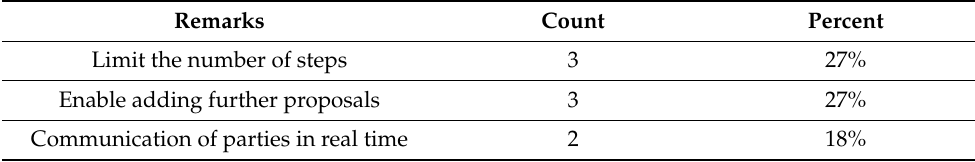
Table 9. Remarks on how to improve the negotiation